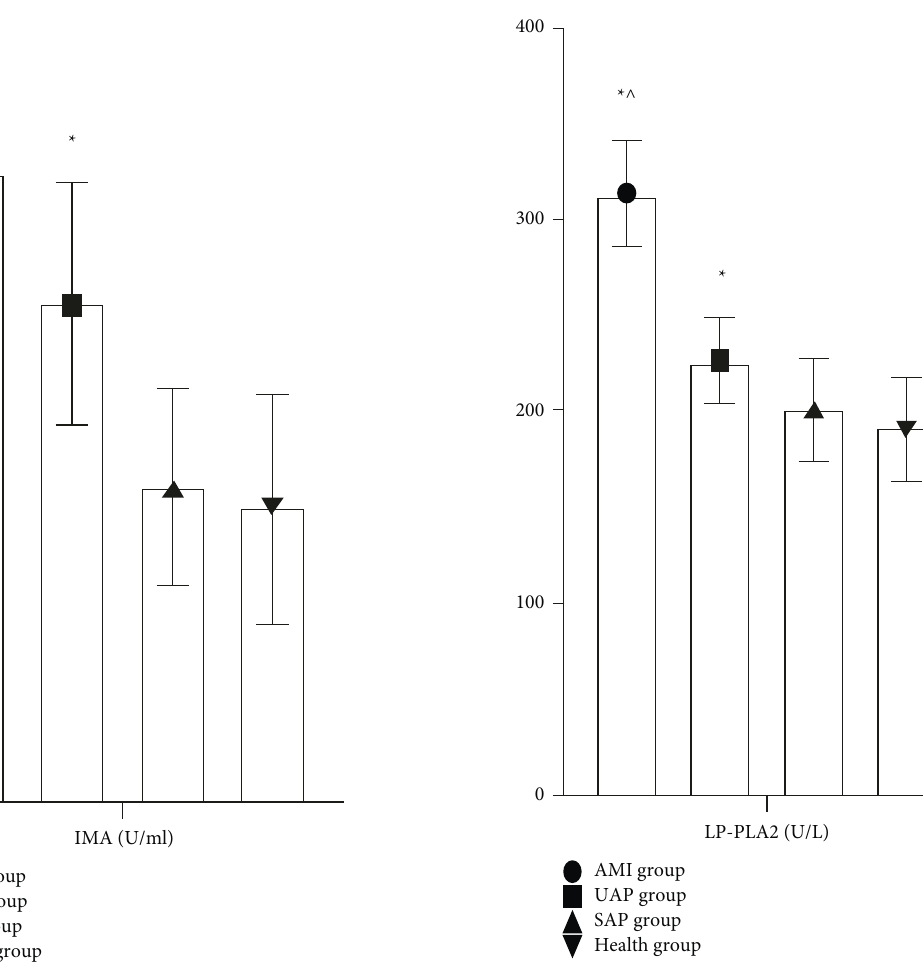
Figure 8: Serum LP-PLA2 level (U/L). Note: ∗ is P < 0 . 05 compared with SAP group and health group, and ^ is P < 0 . 05 compared with UAP group. Table 2: Variable assignment table.